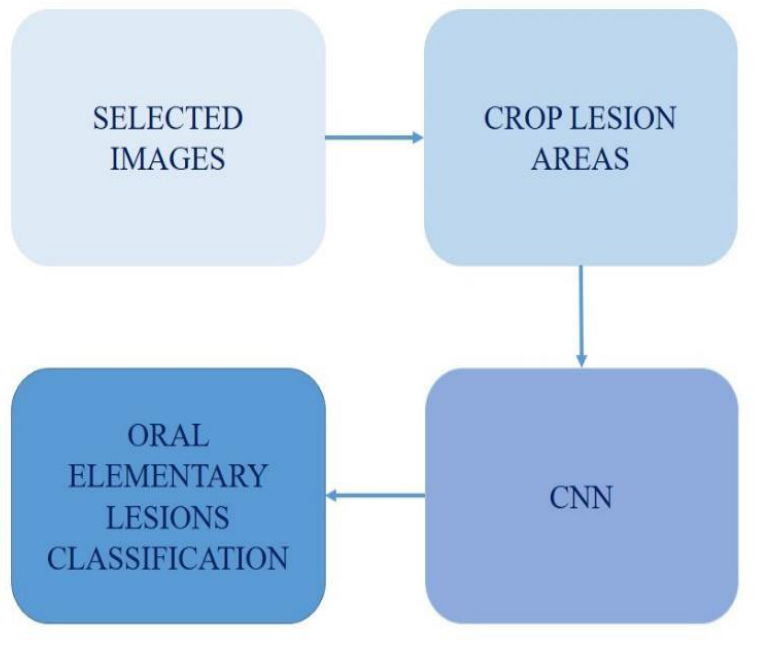
Figure 1. Methodology scheme.